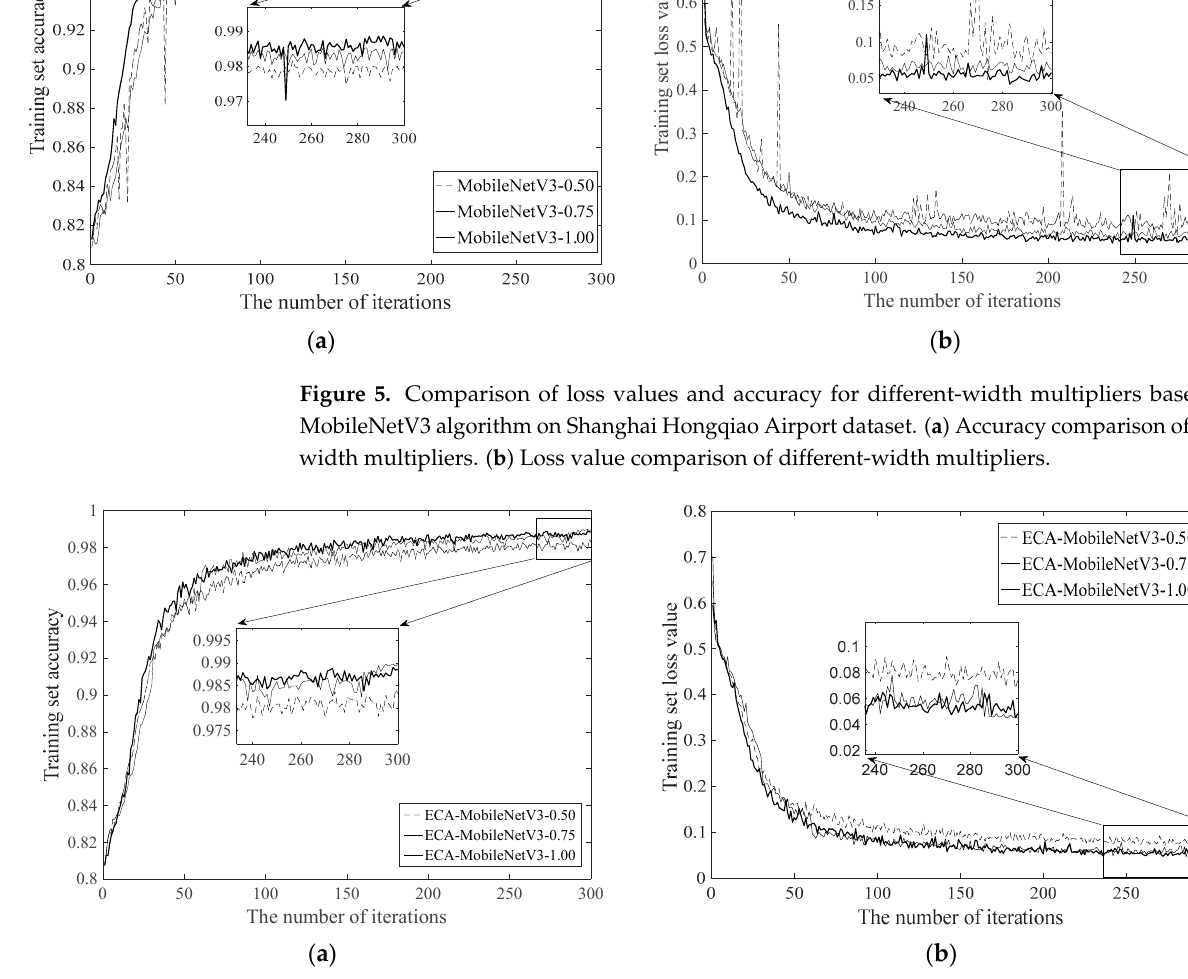
Figure 6. Comparison of loss values and accuracy for different-width multipliers based on the ECA-MobileNetV3 algorithm on Shanghai Hongqiao Airport dataset. ( a ) Accuracy comparison of different-width multipliers. ( b ) Loss value comparison of different-width multipliers.